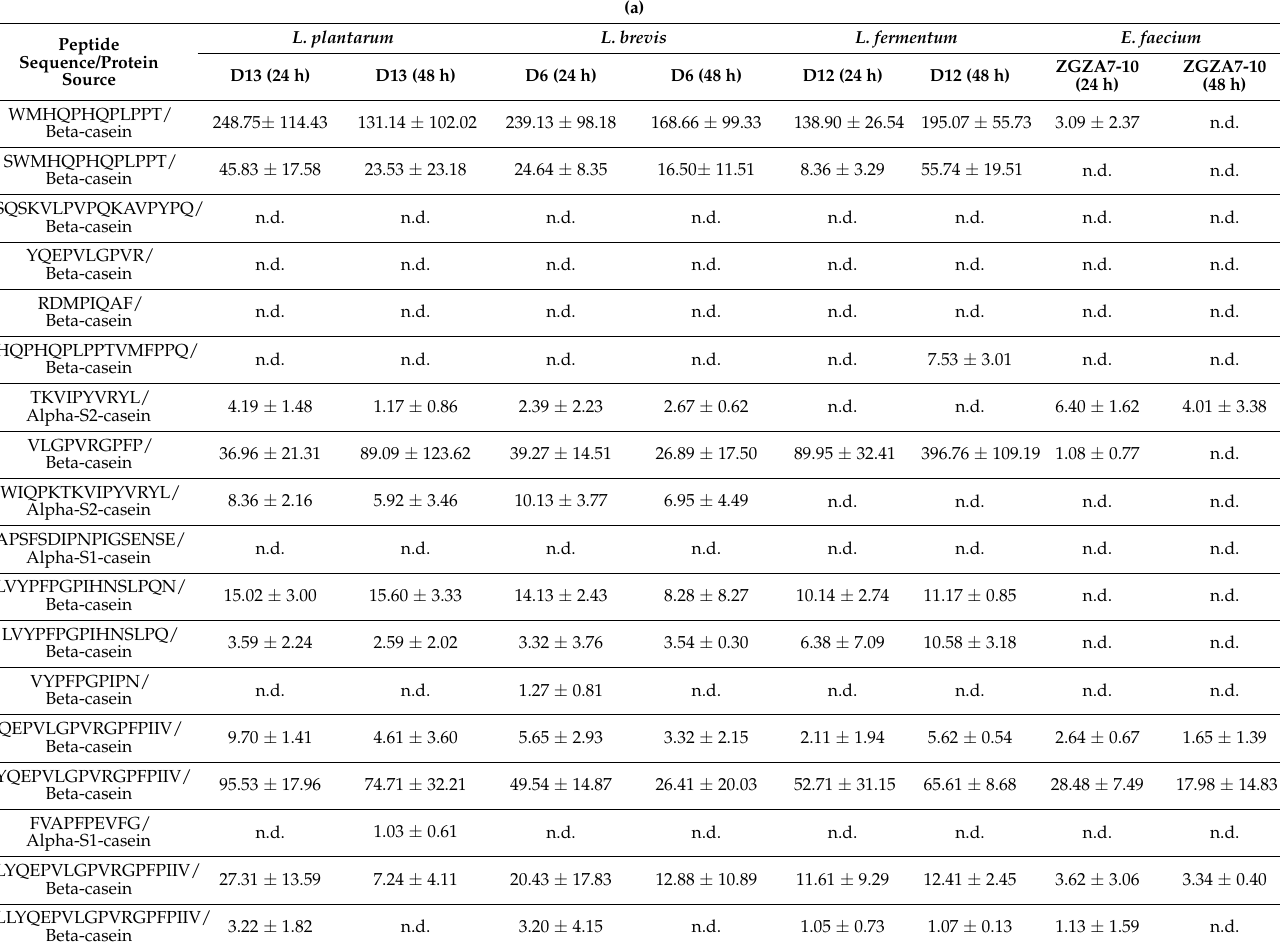
Table 4. The major peptide components of the water-soluble extracts of ( a ) skimmed milk inoculated with individual strains of LAB consortium; ( b ) dried fresh cheese fermented by LAB consortium, control cheese (fermented by DSM CT-203 starter culture), their separated whey, and milk before starter inoculation. Peptides were identified with LC-MALDI-TOF/TOF. Values are normalized data obtained after targeted LC-MRM-MS